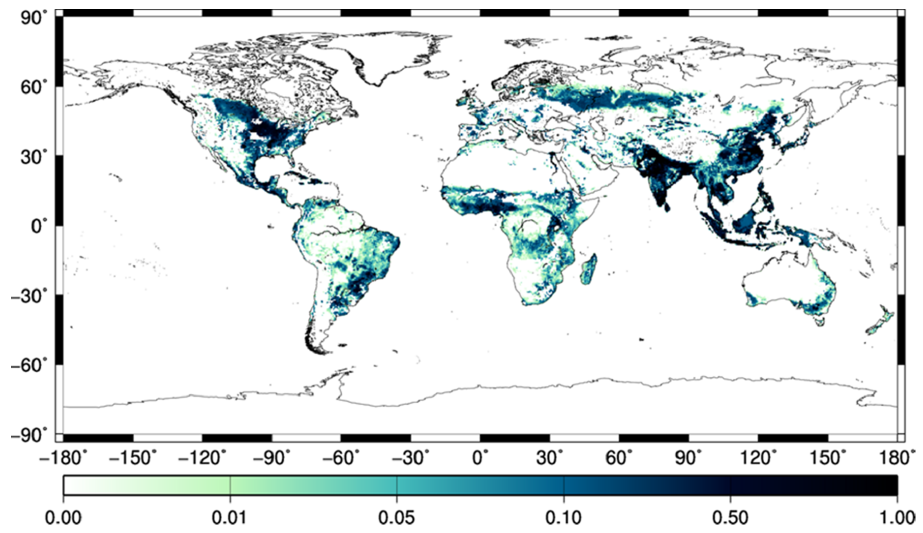
Figure 1. Global distribution of the annual water footprint inventory related to food production between 2001 and 2008 (km 3 /year).